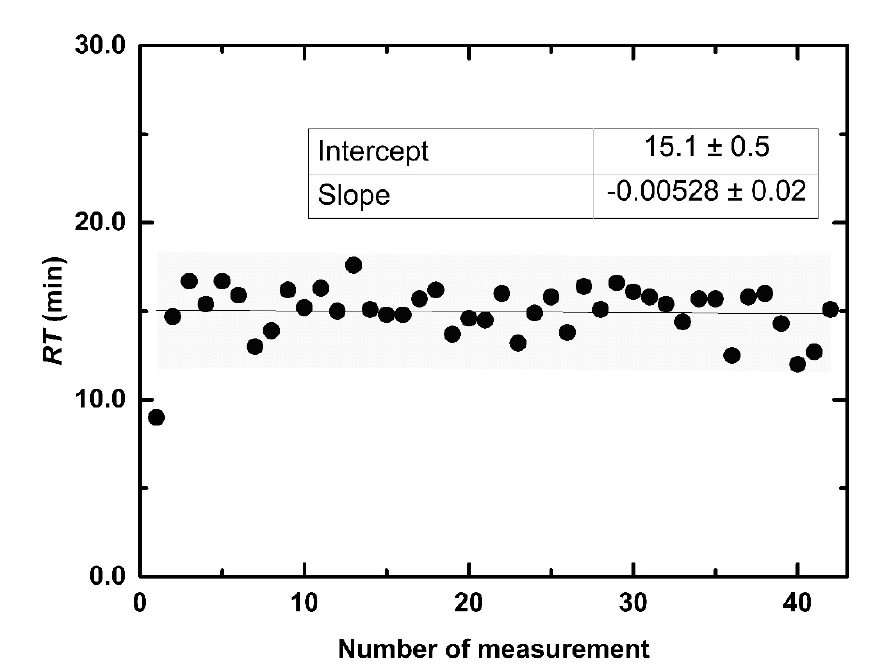
Figure 9. Response time of the optical sensitive layer in 42 repeated measurements during two months.